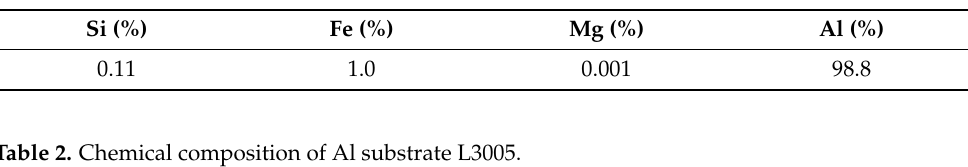
Table 1. Chemical composition and mechanical properties of Al substrate L8079.